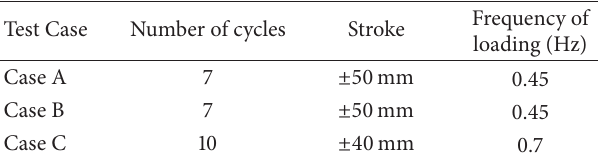
Table 1: Specification of test